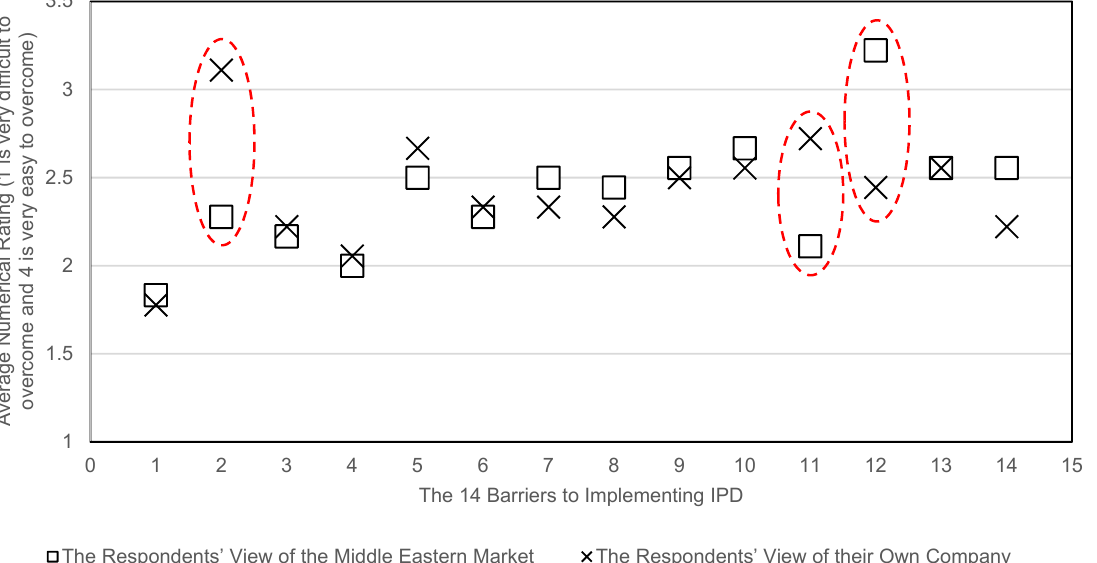
Figure 2. Comparison Chart between the experts’ opinions in the Egyptian Market vs. opinions in their specific companies.